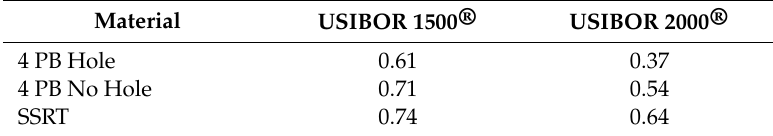
Table 4. Critical hydrogen concentrations of the di ff erent mechanical